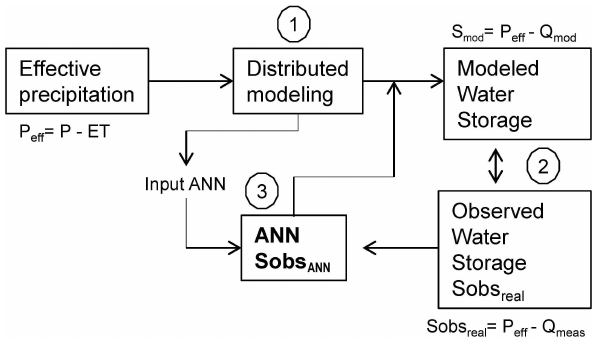
Fig. 2. Overview of the presented method. Effective precip- itation results in modeled runoff. Consistent model mismatch was detected due to water storage deviations. Modeled water storage (derived from hydrological model runoff) systematically over/underestimates observed water storage (derived from mea- sured runoff). The observed water storage is then calculated by the ANN and implemented in the groundwater module to account for the observed storage processes. The ANN is applied to the subcatch- ment